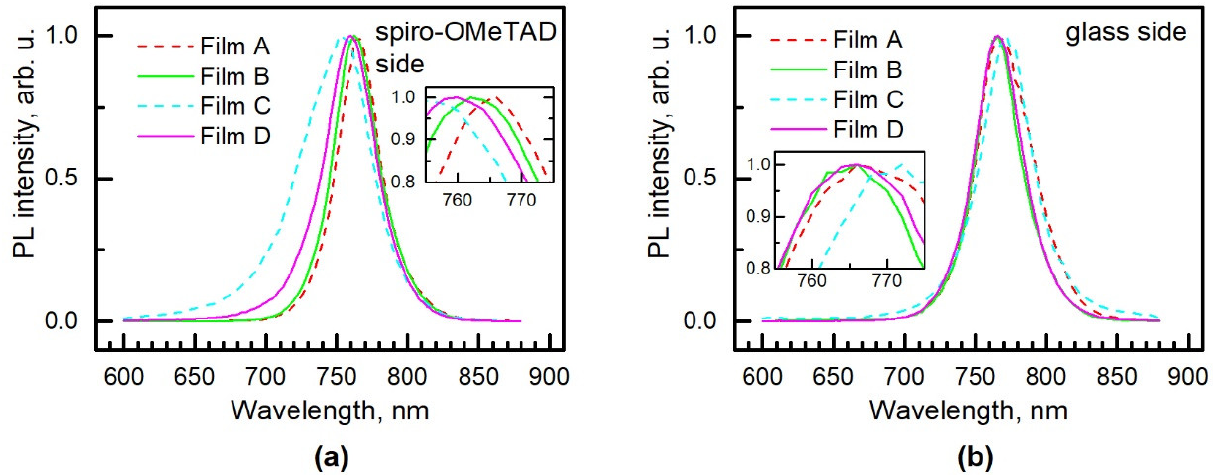
Figure 7. CWPL spectra of PSC measured from ( a ) Spiro-OMeTAD side and ( b ) Glass side. Dashed and solid lines indicate planar and mesoporous structured cells, respectively. The insets show the corresponding enlarged part of peak position.